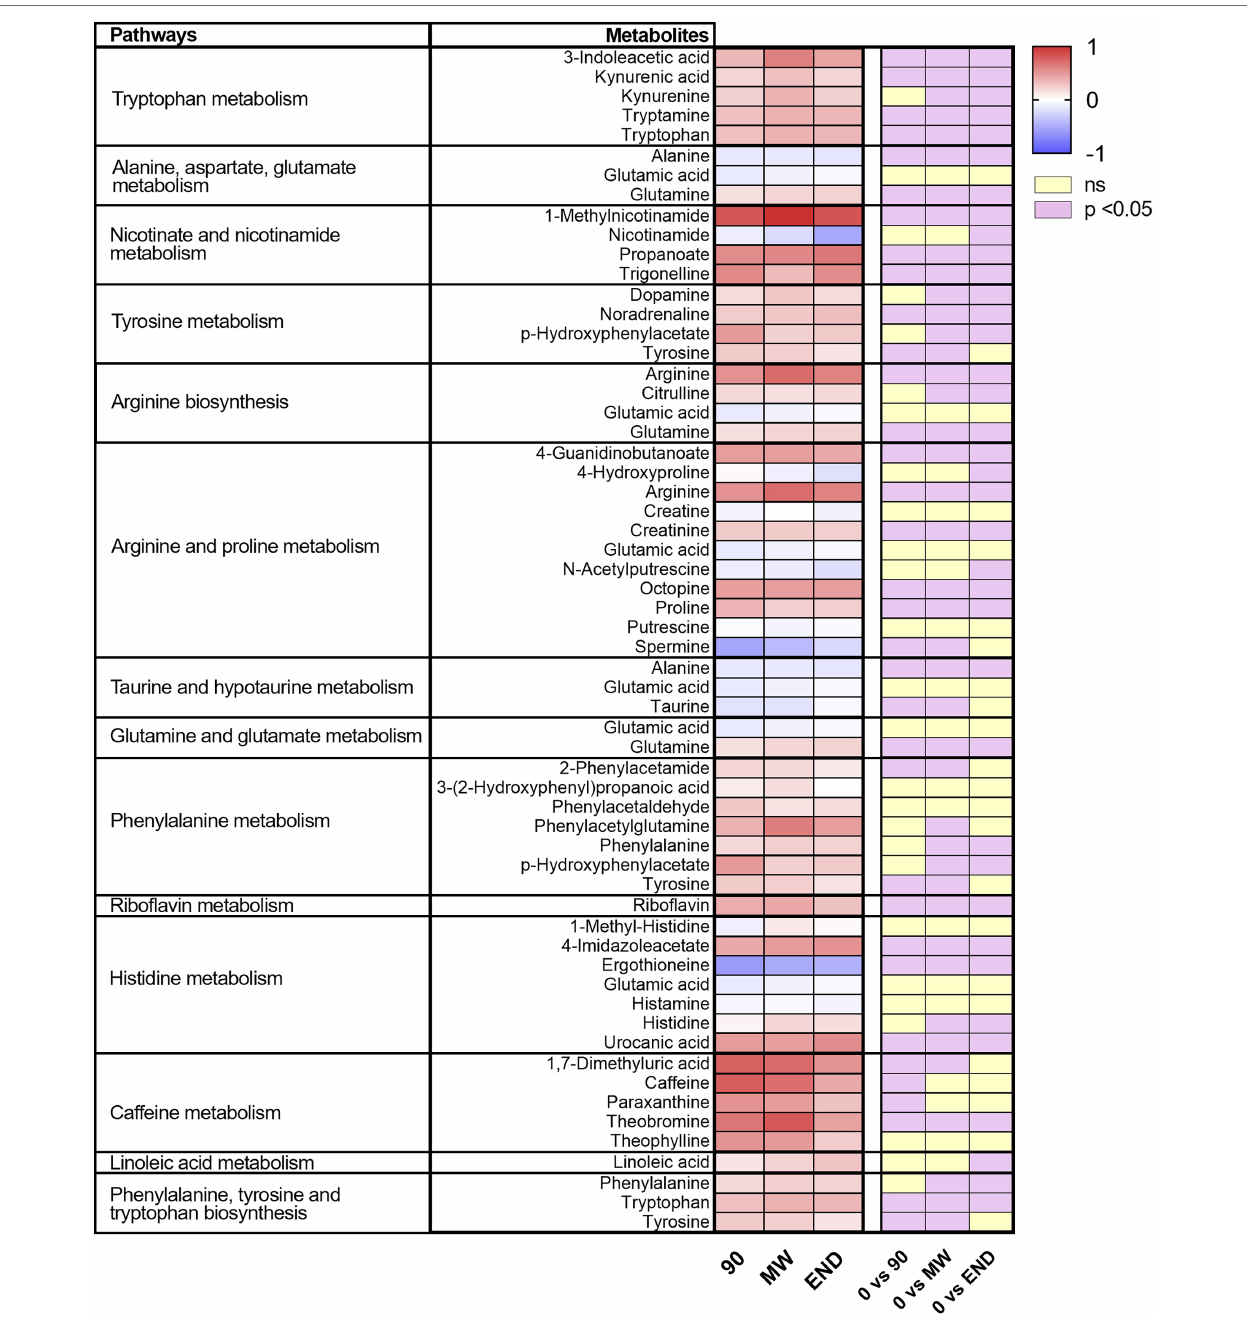
FIGURE 4 | Heat map of the metabolites included in the pathways significantly affected by hypoxia for every time point. On the right, are indicated in violet those significantly modulated by performing one-way ANOVA and the Dunnett post-hoc test; in yellow, those not